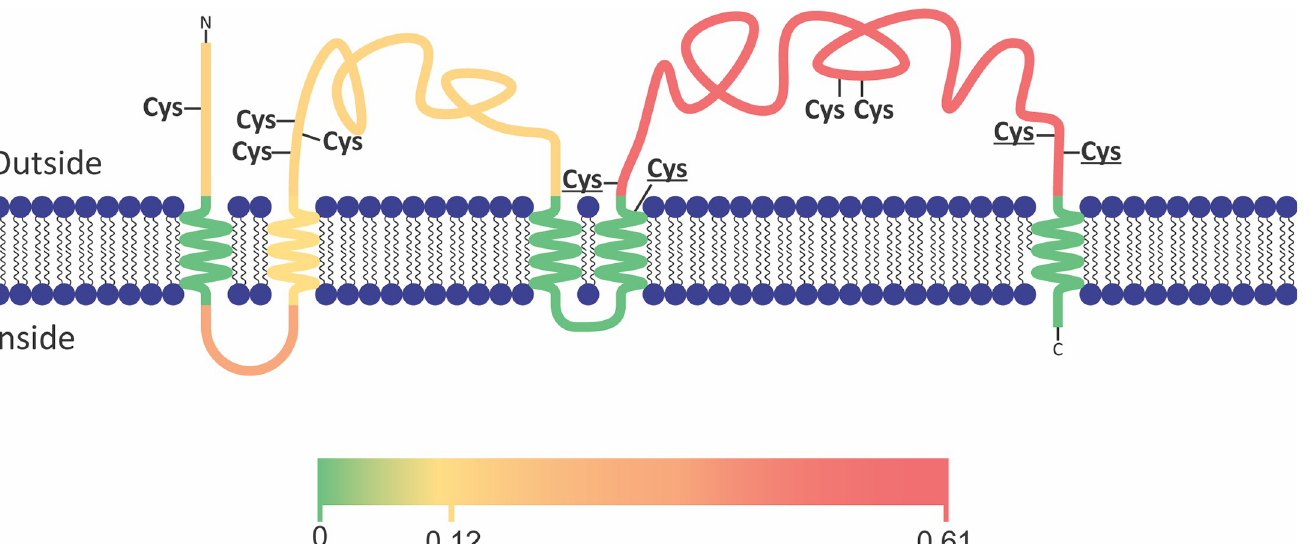
PLOS Computational Biology | https://doi.org/10.1371/journal.pcbi.1008067 April 30,